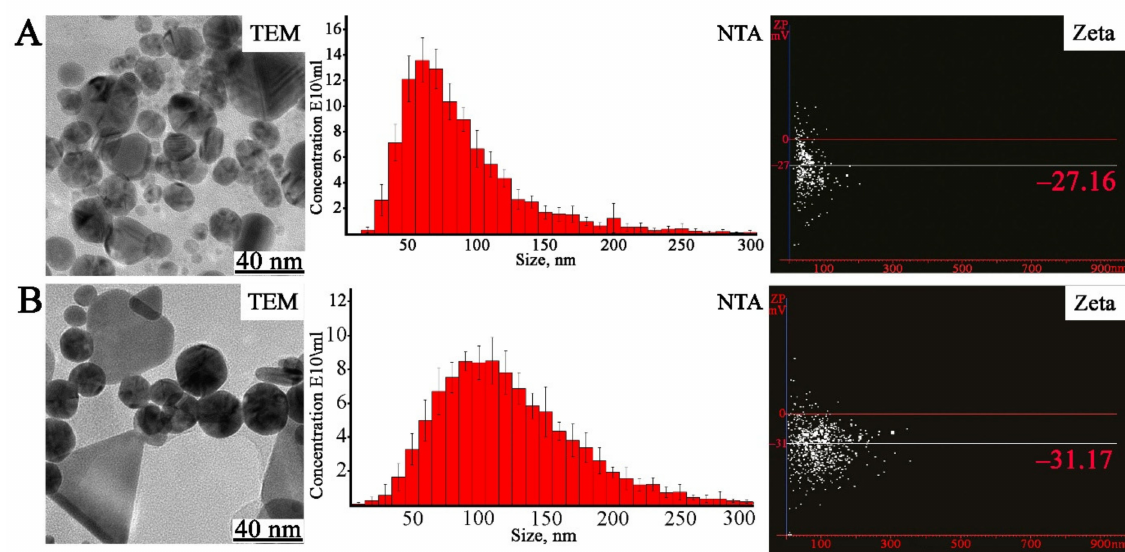
Figure 3. Analysis of AgNPs ( A ) and AuNPs ( B ) synthesized with L . erythrorhizon callus extract. TEM—transmission electron microscopy images of AgNPs and AuNPs; NTA—nanoparticle tracking analysis; Zeta—measurement of electric potential using